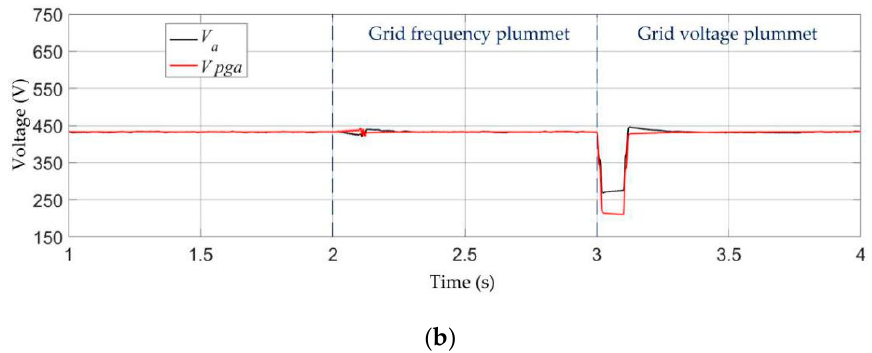
Figure 19. Dynamic response of the system to grid faults: ( a ) the reference frequency f n and the system output frequency f ; and ( b ) the rms value of the system a -phase output voltage V a and the rms value of the grid voltage V pga .